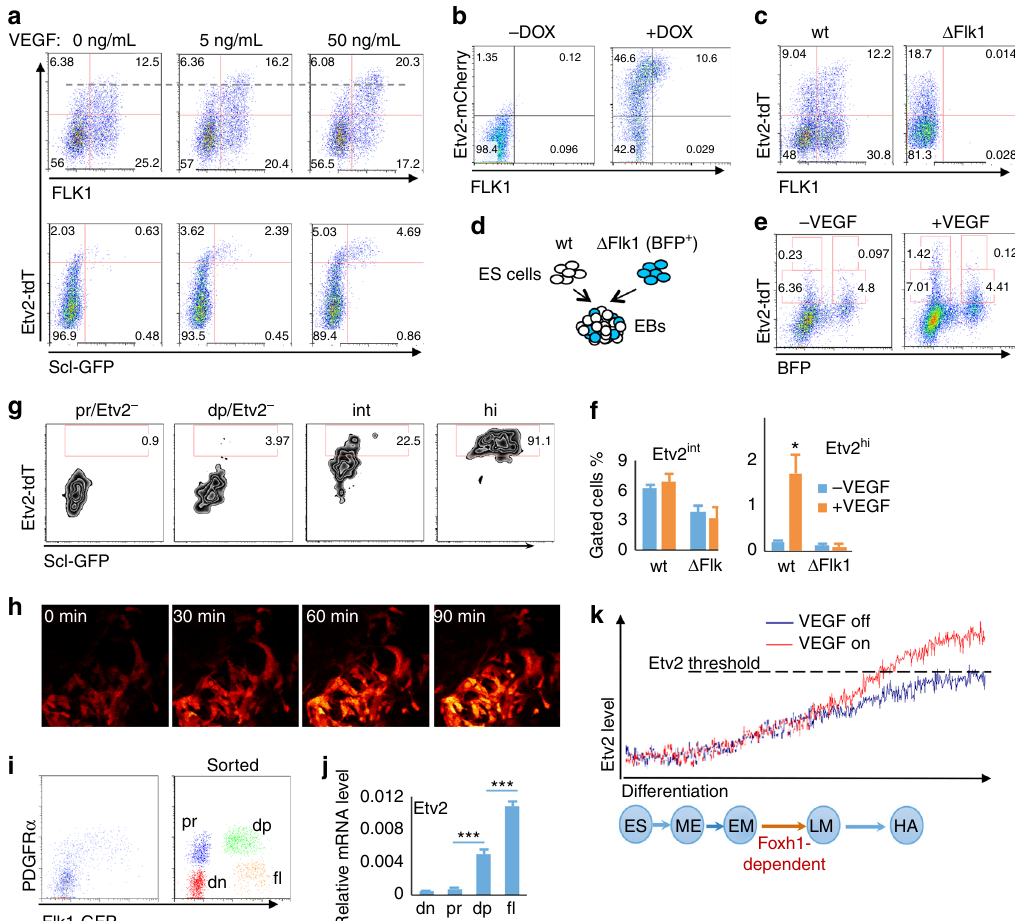
Fig. 6 VEGF-FLK1 signaling regulates Etv2 threshold expression. a Wild-type ( wt ) SGET ES cells were differentiated in different concentrations of VEGF and analyzed for Etv2-tdTomato and Scl-GFP expression on D4. VEGF was added from D3 – 4. b Flow cytometry analysis of ETV2-mCherry and FLK1 in D3.5 iEtv2-mCherry EB cells differentiated in serum-free conditions. DOX (2 μ g/mL) was added from D2.5 to D3.5. c Flow cytometry analysis of D4 wt and Δ Flk1 SGET EB cells for Etv2-tdTomato and FLK1 expression is shown. d Scheme of co-differentiation of wt and Δ Flk1 SGET ES cells is shown. wt and Δ Flk1 SGET ES cells were mixed at a 4:1 ratio and co-differentiated as described in Experimental procedures. e Response of wt and Δ Flk1 SGET D4 EB cells to VEGF is shown as Etv2 high cell generation. VEGF (50 ng/mL) was added from D3 – 4. BFP-negative cells depict wt and BFP-positive cells depict Δ Flk1 cells. f Percentages of Etv2 int and Etv2 high cells within wt and Δ Flk1 SGET EB cells. g Sorted populations as indicated from D4 SGET EBs were re-seeded onto OP9 cells and analyzed 12 h later for Etv2-tdTomato and Scl-GFP by fl ow cytometry. h Live imaging of SGET cells responding to VEGF. Black regions in the pictures are occupied by Etv2-tdTomato negative cells, Etv2-tdTomato int cells are in red and Etv2-tdTomato hi cells are in orange . ( i ) FACS plot of D3 Flk1 GFP/GFP EB cells used for cell sorting, PDGFR α − GFP − ( dn ), PDGFR α + GFP - ( pr ), PDGFR α + GFP + ( dp ), and PDGFR α − GFP + ( fl ) cells, is shown. Etv2 expression in “ dn ” , “ pr ” , and “ dp ” cells isolated from D3 Flk1 GFP/GFP EB cells is shown in j . k A model showing hemangiogenic progenitor development. The blue circles indicate different stages during mesoderm differentiation ( ES undifferentiated ES cells, ME mesendoderm, EM early mesoderm, LM lateral mesoderm, HA hemangiogenic progenitors). The zigzag curves at the top indicate the stochastic fl uctuation of Etv2 expression. Activation of the hemangiogenic program rarely occurs in the absence of VEGF signaling ( blue line ). However, when the VEGF signaling is active, the hemangiogenic fate can be ef fi ciently achieved through the promotion of Etv2 threshold expression ( red line ). * P value < 0.05 in Student ’ s t test, *** P < 0.001, and n = 3. Error bars are To further understand how Foxh1 regulates FLK1 + mesoderm Mixl1 , Eomes , Tbx3 , Gsc , and Mesp1 expression was signi fi cantly reduced in Δ Foxh1 “ pr ” cells compared to wild-type “ dp ” cells generation, we compared transcriptome of Foxh1 -de fi cient “ pr ” cells (Fig. 4h). Therefore, not just the surface marker FLK1, but the to those of wild-type mesoderm intermediates ( “ dn ” , “ pr ” , or “ dp ” ) speci fi c transcriptional program in FLK1 + mesoderm, was blocked (Fig. 4f and Supplementary Datas 11, 12). Overall, the gene by the Foxh1 de fi ciency. Consistent with Foxh1 ’ s role in gastrulation, expression pattern of Δ Foxh1 “ pr ” cells was close to other mesoderm gene set enrichment analysis (GSEA) 40 of genes downregulated in samples. Most of the nascent/early mesoderm genes enriched in “ pr ” Δ Foxh1 “ pr ” cells showed signi fi cant enrichment of genes that cells were already upregulated in Δ Foxh1 “ pr ” cells, but at a reduced correlate to T expression in the early gastrulating embryo 41 (Fig. 4i level compared to wild-type “ pr ” cells (Fig. 4g, Supplementary and Supplementary Fig. 4e). These fi ndings reinforce the notion that Fig. 4d, top , and Supplementary Data 11). In particular, most of the Foxh1 is required for FLK1 + mesoderm induction. genes enriched in “ dp ” cells were more prominently reduced in Δ Foxh1 “ pr ” cells compared to wild-type “ dp ” cells (Supplementary Eomes functions downstream of Foxh1 in FLK1 + cell genera- Fig. 4d, bottom , and Supplementary Data 11). Among the transcription factors that were extensively expressed in “ dp ” cells, tion . Previous studies have shown that Foxh1 directly activates